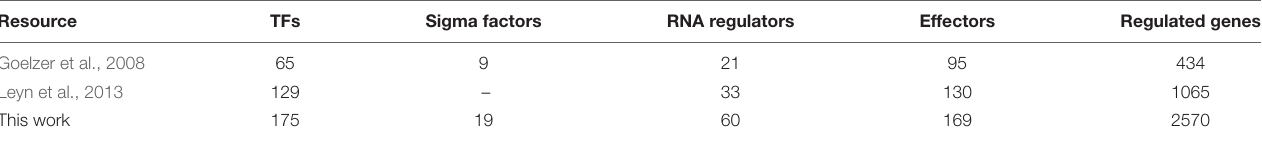
TABLE 1 | Comparison between notable resources for Bacillus subtilis regulatory network modeling.